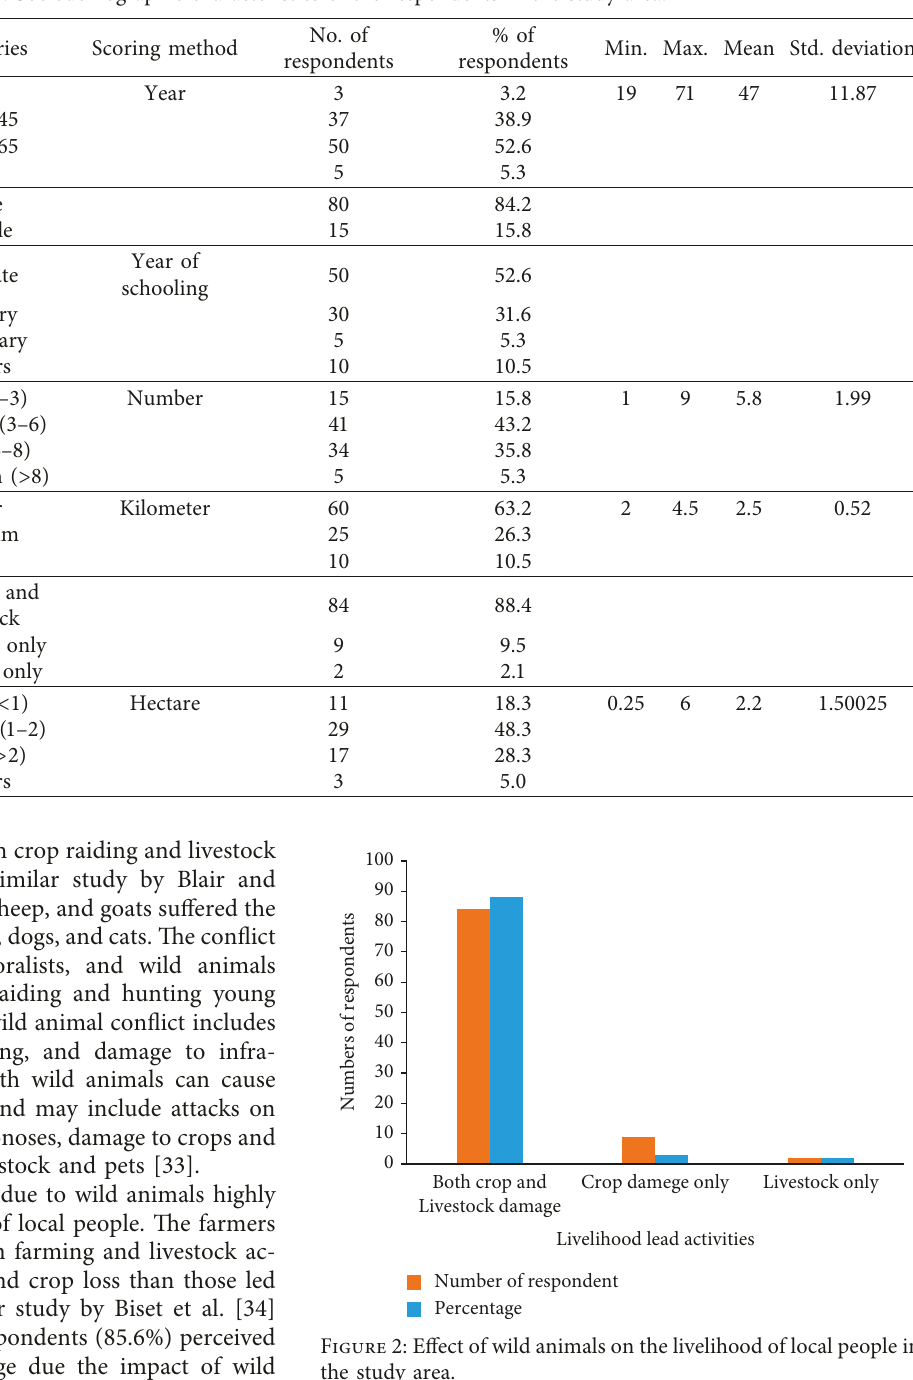
Table 1: Sociodemographic characteristics of the respondents in the study area.